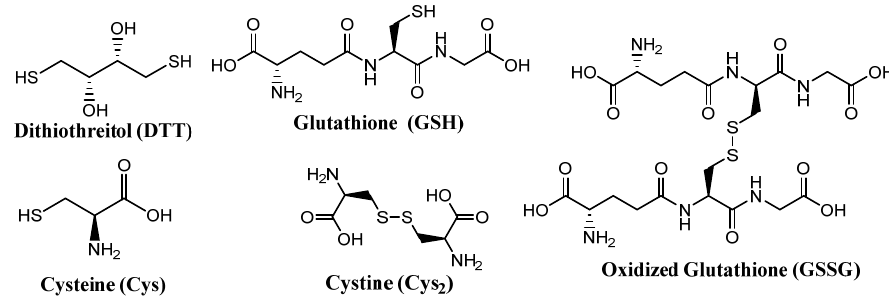
Figure 2. Structures of some biologically important thiols and disulfides.